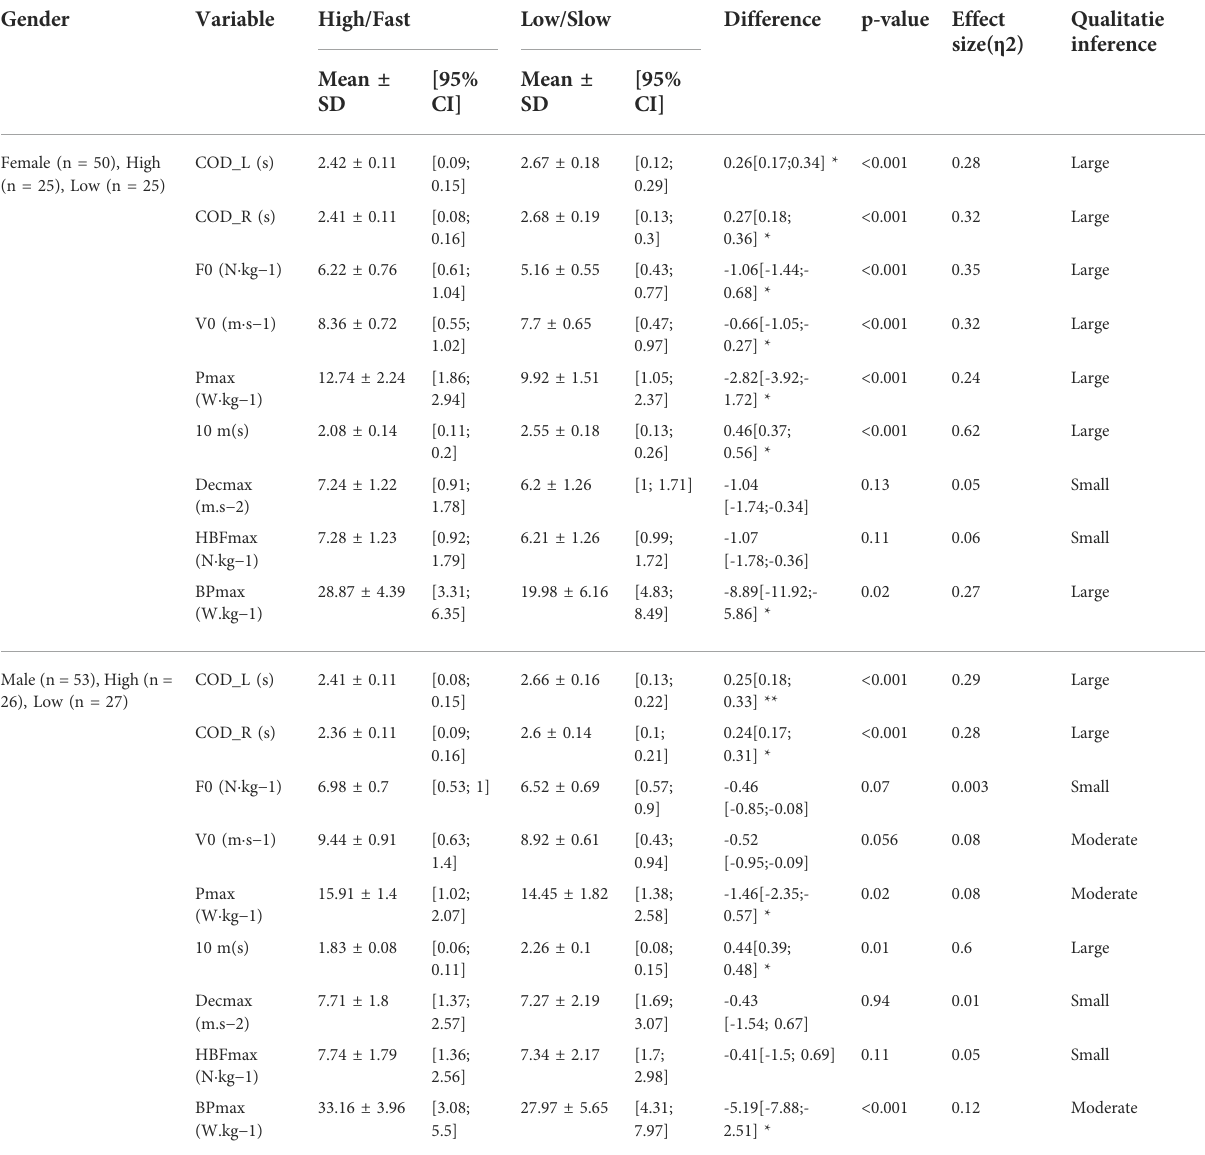
TABLE4Kinematicandkineticvariablesduringtheacceleration,deceleration,andCODperformanceontheleftside(COD_L)andrightside(COD_R) were displayed by gender (Male vs. Female) and COD performance (High vs. Low), and the comparison by the COD performance. F 0 : maximal theoreticalforce;V 0 :maximal theoretical velocity;P max :maximalpower;10 m:10 msplit time;HBF max :maximum brakingforce;HBP max :maximum braking power; Dec max : maximum deceleration. All data are presented as mean ± standard deviation with a 95% con fi dence interval. * Signi fi cant difference from COD